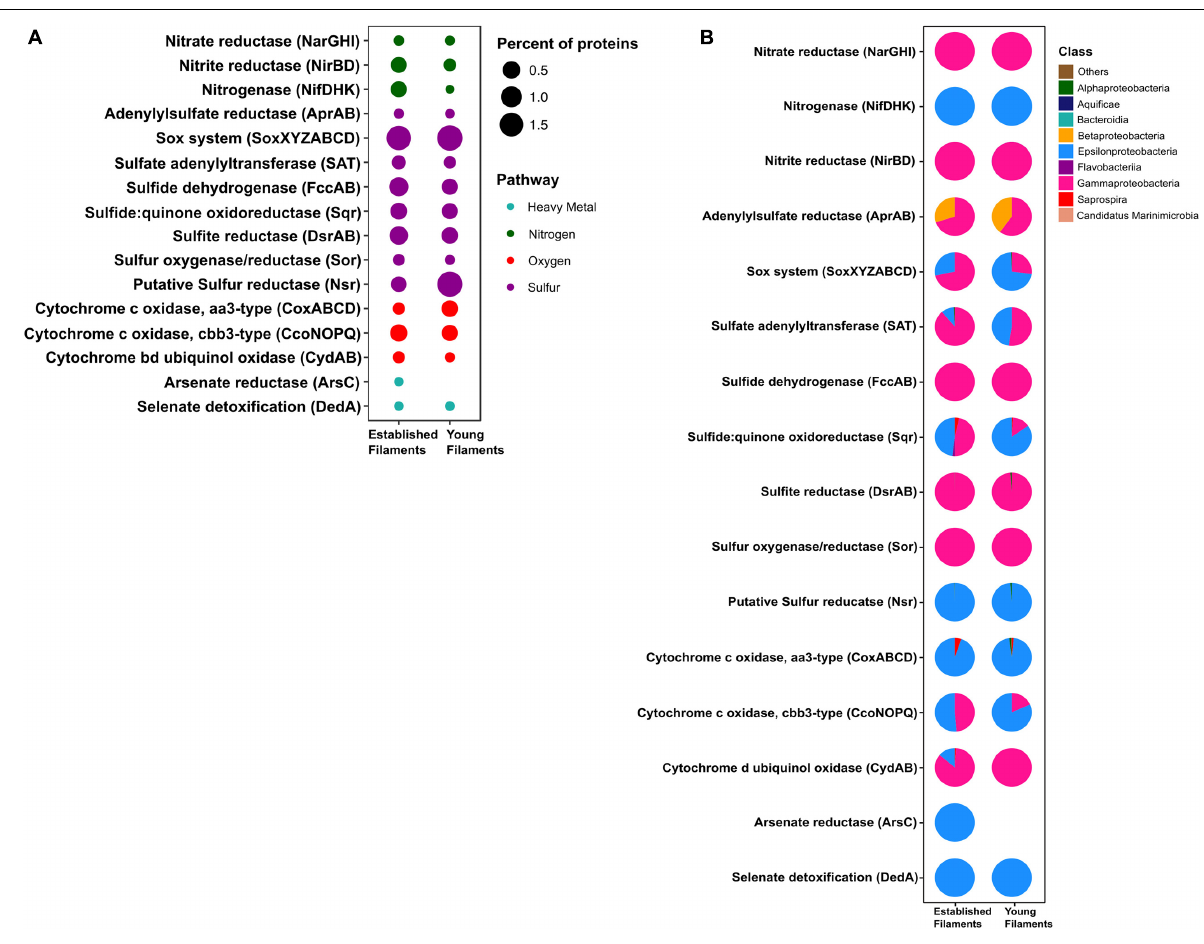
FIGURE 4 | (A) Percentage and (B) taxonomic affiliation of key proteins involved in nitrogen, sulfur, oxygen and heavy metal detoxification pathways for established and young